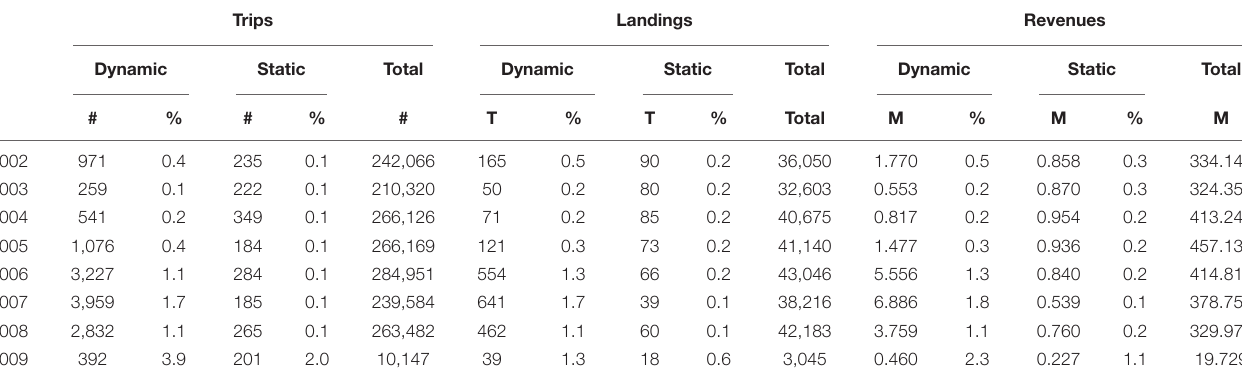
TABLE 2 | Total trips, landings (metric tons) and landed value (revenues in millions of US$2012) and percent of total for the Dynamic Area Management (DAM) zones, the static whale-modified-gear areas and for entire area north of 40-degree north latitude from shore east to the Exclusive Economic Zone. Trips Landings Revenues Dynamic Static Total Dynamic